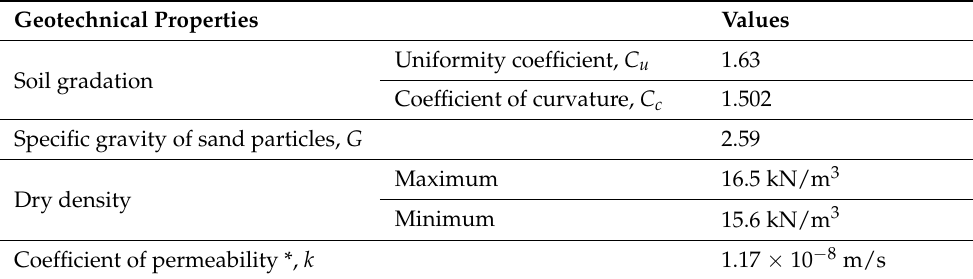
Figure 1. Particle size distribution of sand. Table 1. Geotechnical properties of fine sand prior to saltwater submergence